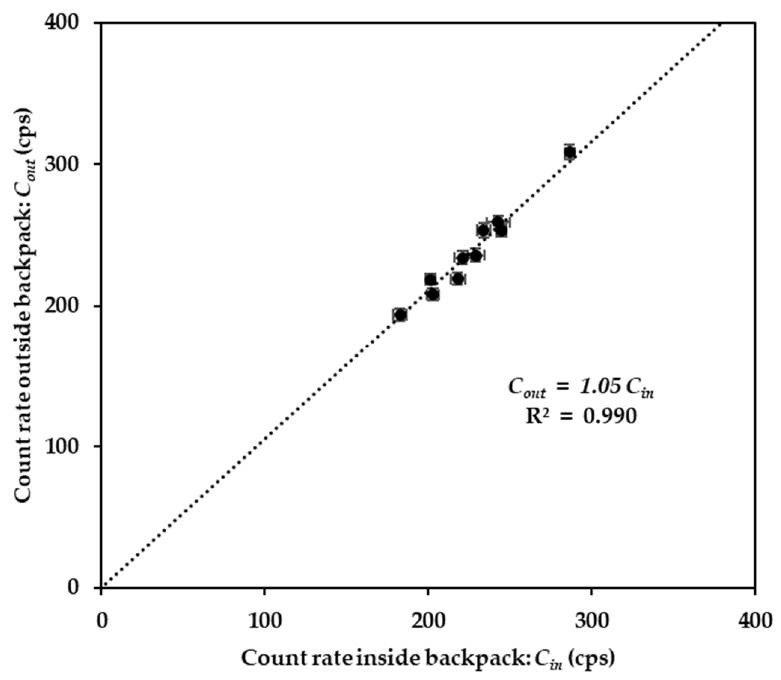
Figure 3. Correlation between count rates outside and inside the backpack.